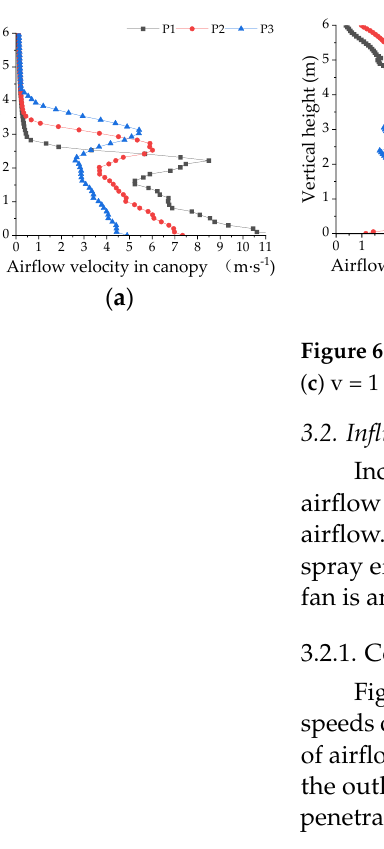
Figure 6. Distribution of air speed in the canopy at different driving speeds. ( a ) v = 0 m/s, ( b ) v = 0.5 m/s, ( c ) v = 1 m/s, ( d ) v = 1.5 m/s.